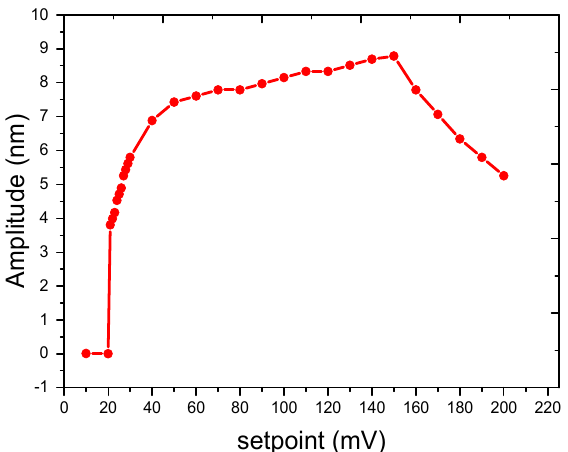
Figure 6 . Amplitude response measured at different amplitude setpoints in tapping mode in fluid.